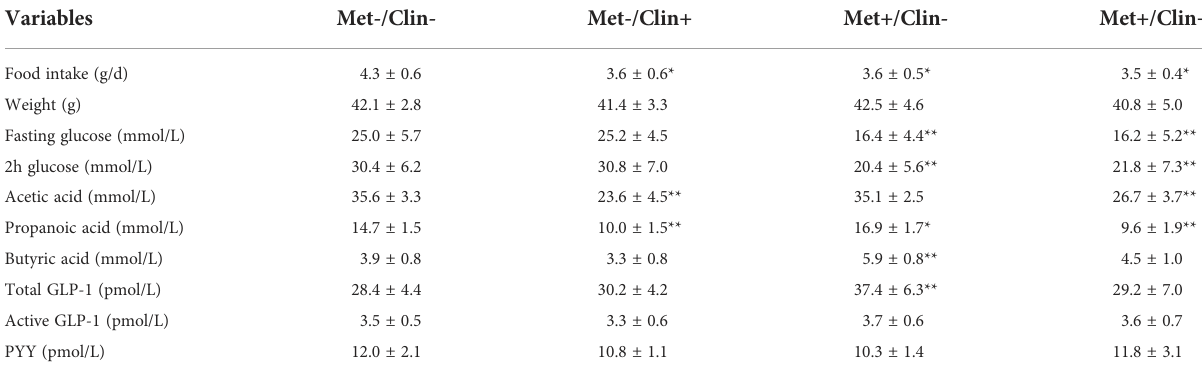
TABLE 2A Characteristics of mice in experiment A (after treatment).